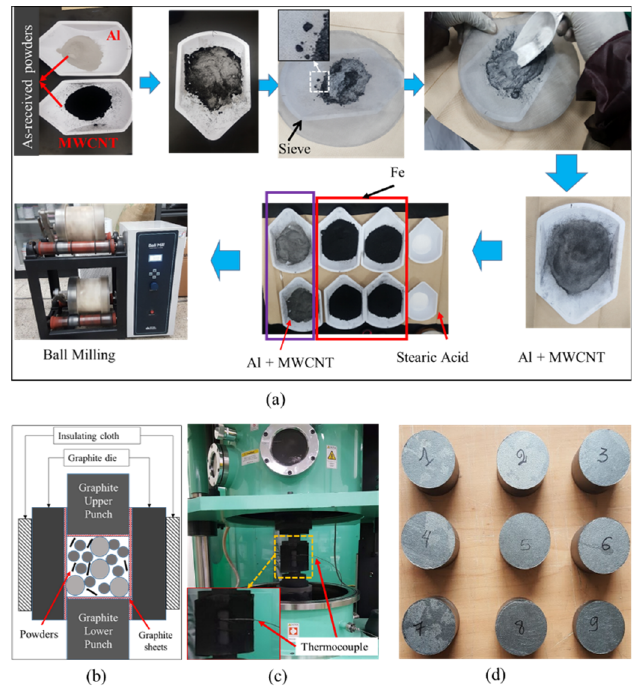
Figure 2. Sample preparation: ( a ) powders mixing procedures; ( b ) model of die-powders-punches system preparation; ( c ) mounting the die-powders-punches system in the spark plasma sintering (SPS) machine and ( d ) sintered samples.